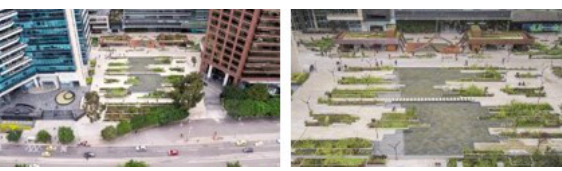
Figure 4: Usaquén Urban Wetland, Bogota, Colombia [URL6]